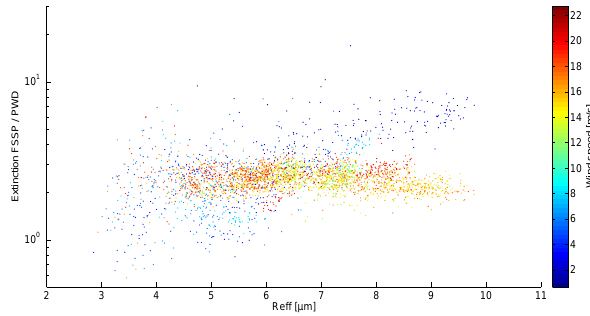
Figure 14. Extinction ratio between the FSSP and the PWD as a function of effective radius of cloud droplets and ambient wind speed during the ROSEA